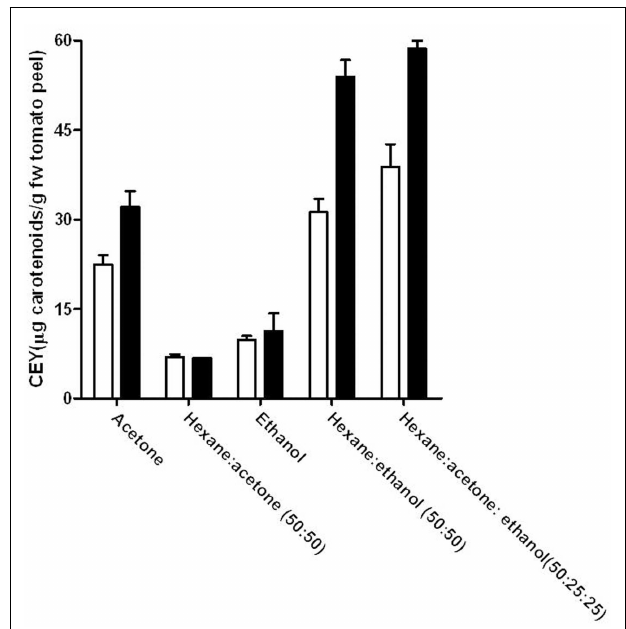
FIGURE 3 | Influence of the solvent extraction mixture on the carotenoid extraction yield (CEY) from control (white bars) and